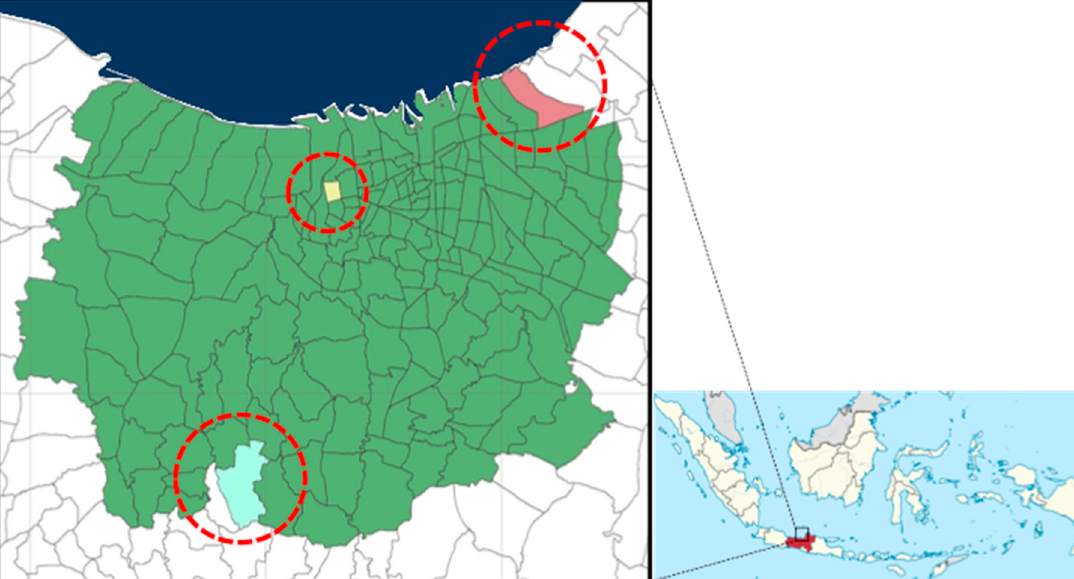
Figure 2. Location map of Semarang (left image; in green) with respect to Indonesia (right image), Central Java (red in right image) and Semarang case study areas (left image): Trimulyo (in pink), Karangayu (in yellow) and Gunung Pati (in turquoise). RF of 1:267,000. Table 1. Social profile of Semarang’s three case study areas (2017 data from Semarang Central Bureau of Statistics